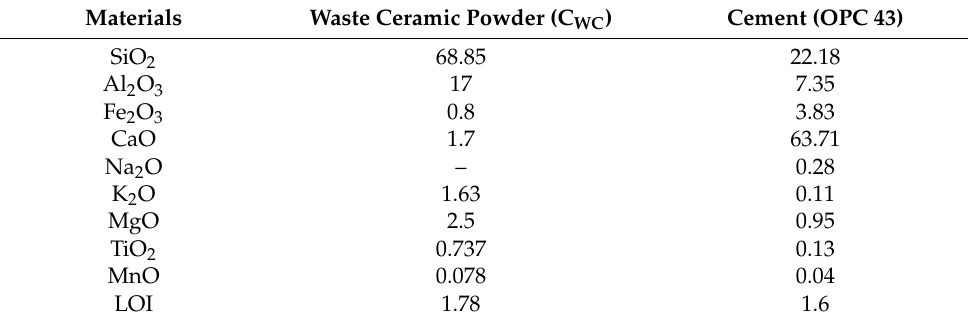
Table 2. Chemical analysis of C WC and cement (OPC 43).